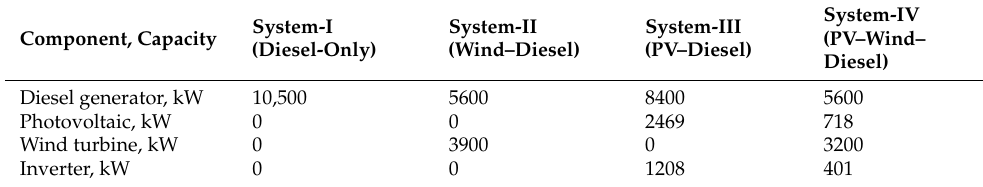
Table 7. Capacity detailed of each components in different optimal system